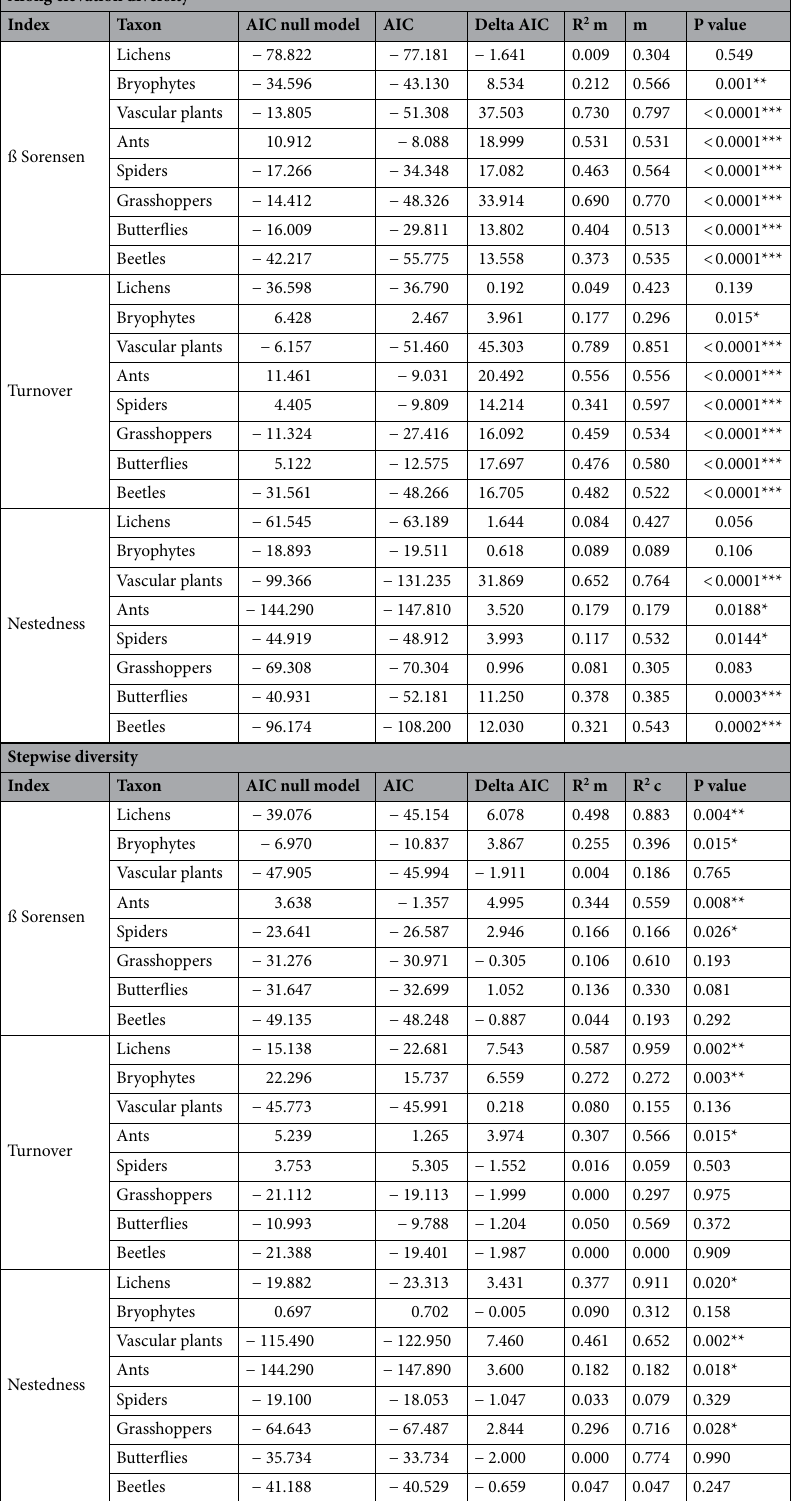
Table 1. Results of mixed effect models testing the effect of elevational distance for overall beta (ß Sorensen) diversity and the components turnover and nestedness performed separately for along elevation and step- wise diversity for each taxonomic group. AIC Null Model = is the AIC (Akaike information criterion) of the model without elevational distance as fixed factor, AIC = is the AIC of the model including elevational distance, Delta AIC is the difference of the applied model to the Null-Model. R 2 m… marginal, R 2 c… conditional. Significance levels: *...0.01–0.05, **...0.001–0.01,